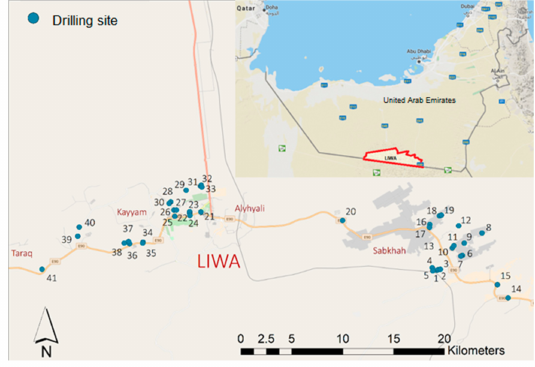
Figure 1. Locations of drilling